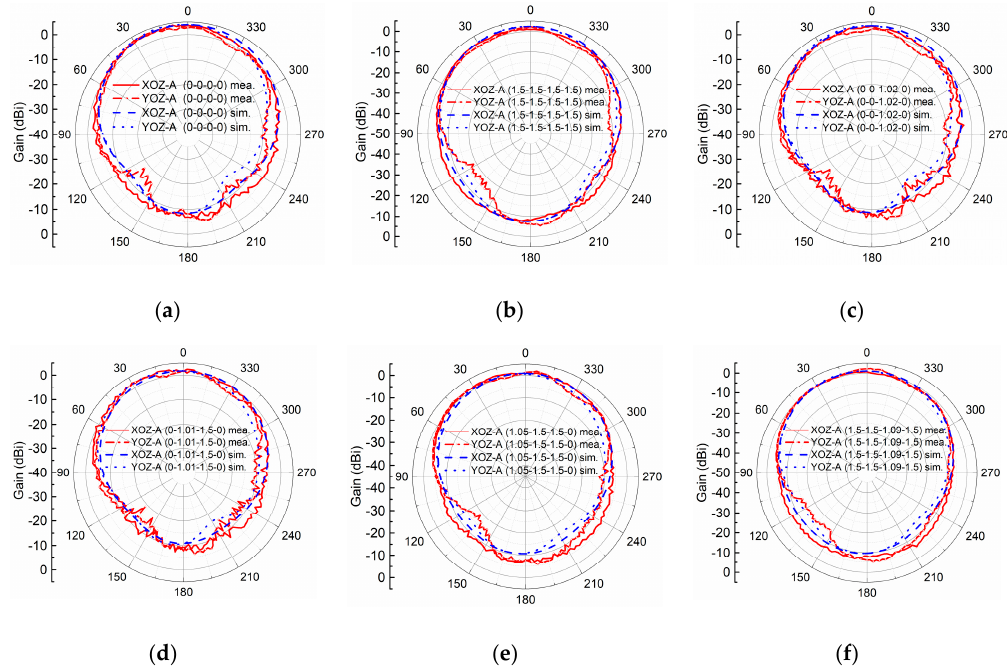
Figure 10. Comparisons between simulated and measured radiation patterns of the two extreme states: ( a ) 0-0-0-0 and ( b ) 1.5-1.5-1.5-15, and four nonlinear states: ( c ) 0-0-1.02-0, ( d ) 0-1.01-1.5-0, ( e ) 1.05-1.5-1.5-0, and ( f ) 1.5-1.5-1.09-1.5.